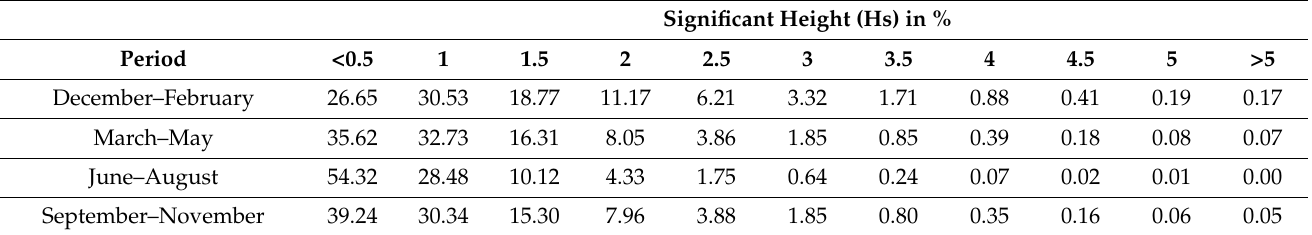
Table 1. Average seasonal Distribution for the area 1. Source: Authors.